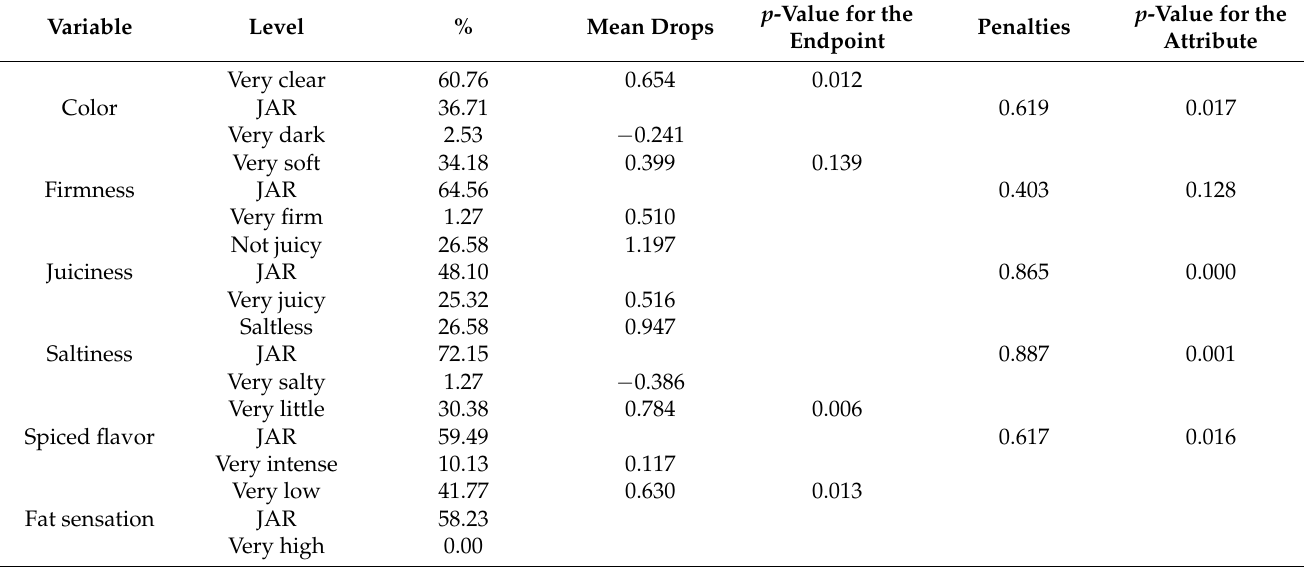
Table 8. Penalty analysis for reduced-fat pork and chicken meatballs without preservatives (AI).